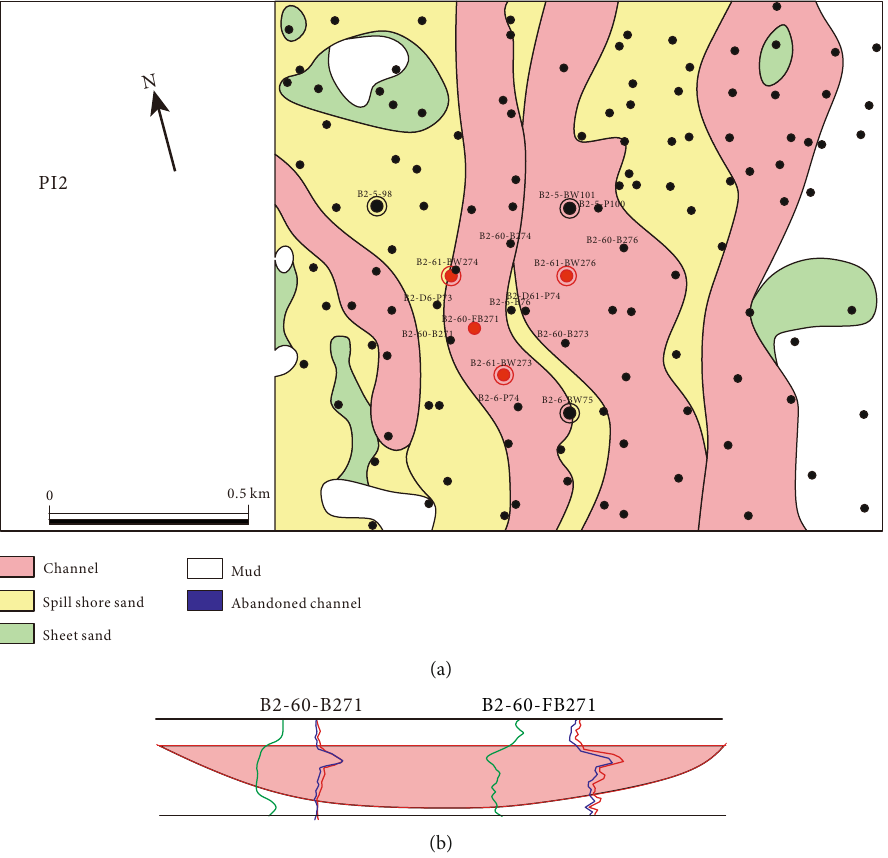
Figure 6: (a) Plane view of the channel patterns in the PI2 layer. (b) Vertical pro fi le of the channel in the PI2